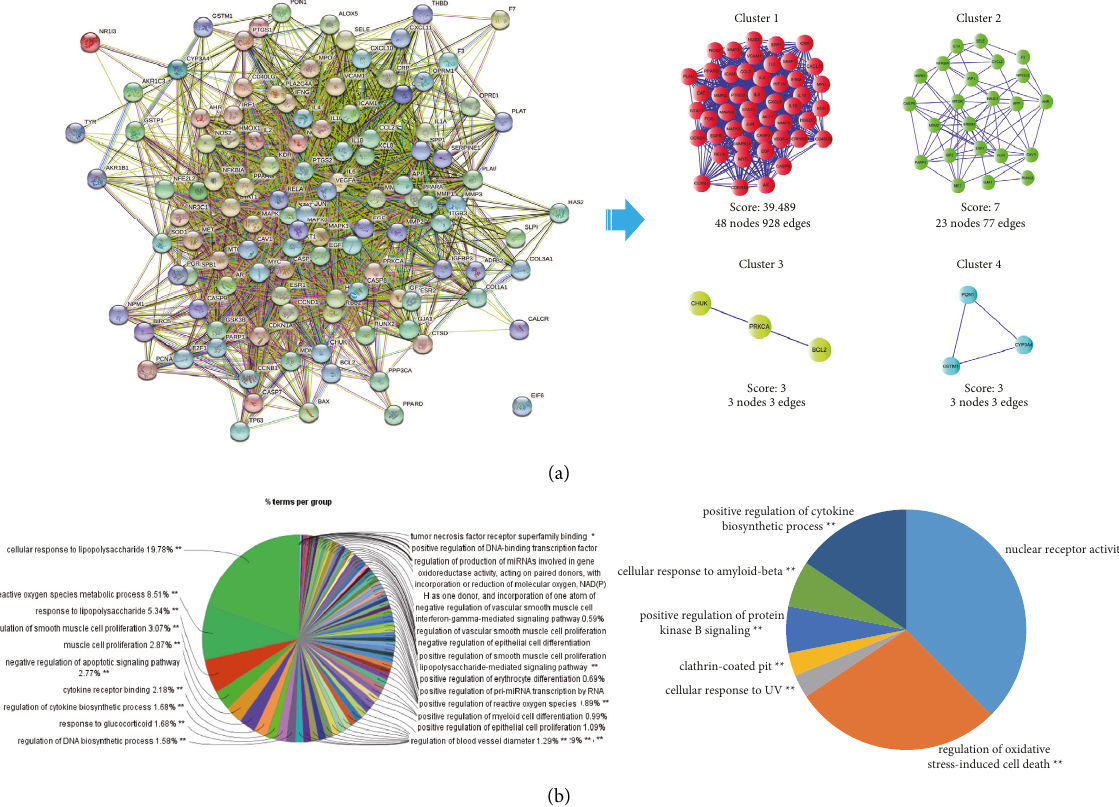
Figure 6: PPI network and GO enrichment analysis. (a) The PPI network of Quzhi decoction treatment on knee OA. Module analysis was carried out by MCODE. (b) GO enrichment analysis of Cluster 1 and Cluster 2 by ClueGO. Table 2: Information on key targets, metabolites, and pathways. Related pathways Key targets Key